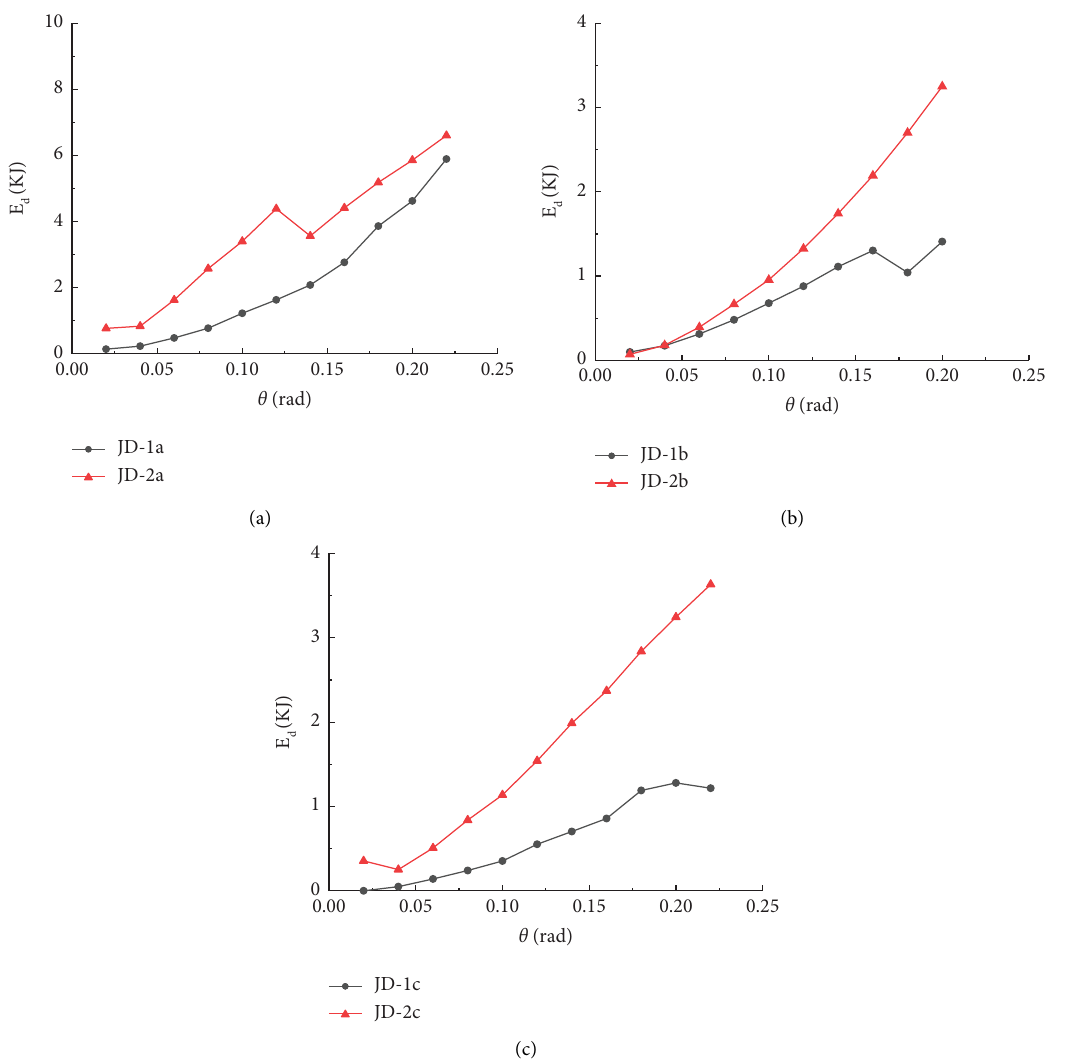
Figure 11: Hysteresis curve energy consumption area comparison: (a) Tou mortise-tenon joints. (b) Ban mortise-tenon joints. (c) Dovetail mortise-tenon